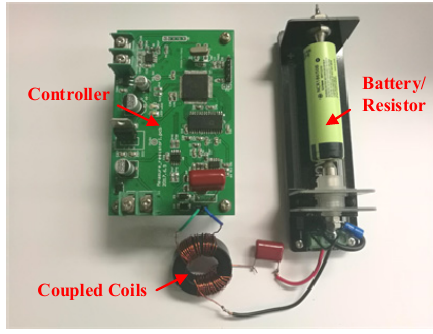
Figure 9. Experimental platform.